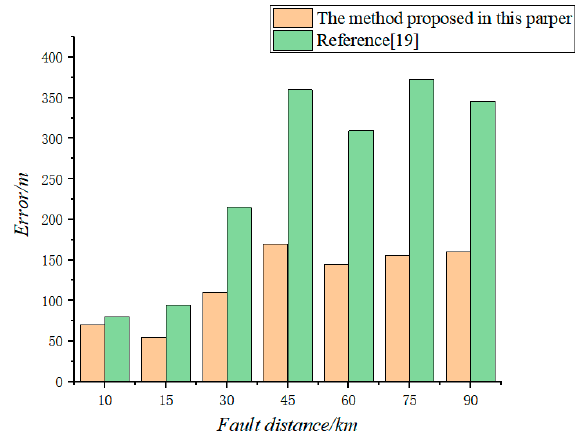
Figure 3. The comparative experimental results of this paper and Raphael et al. [19].